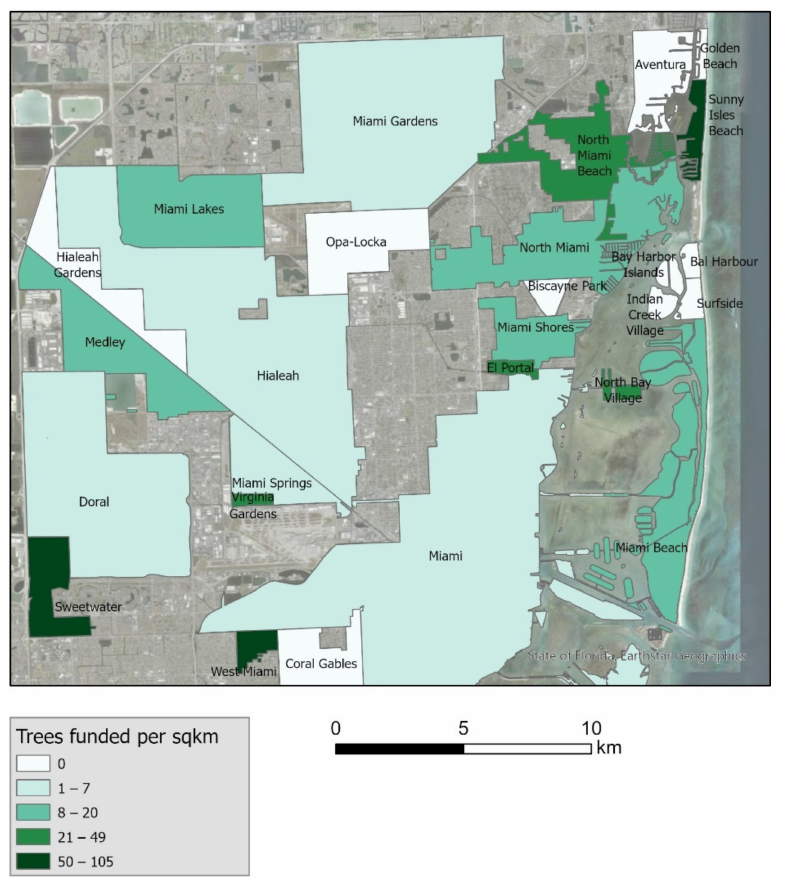
Figure 10. New trees planted per km 2 in selected municipalities of Miami-Dade County between 2016 and 2019 based on funding from the Million Trees Miami initiative (background map credits: State of Florida, Earthstar